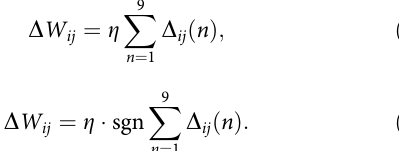
NATURE COMMUNICATIONS|8:15199|DOI: